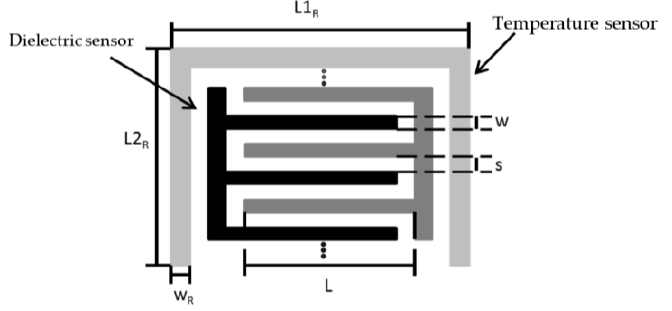
Figure 2. Schematic of the sensor (top view). The interdigital structure in the middle consists of N = 150 electrodes with width w = 10 µm and spacing s = 10 µm. The length is L = 6 mm. The resistive structure has a total length of 𝐿 𝑅 = 2 × 𝐿2 𝑅 + 𝐿1 𝑅 = 2 × 3.89 mm + 6.17 mm = 13.95 mm and a width of 40